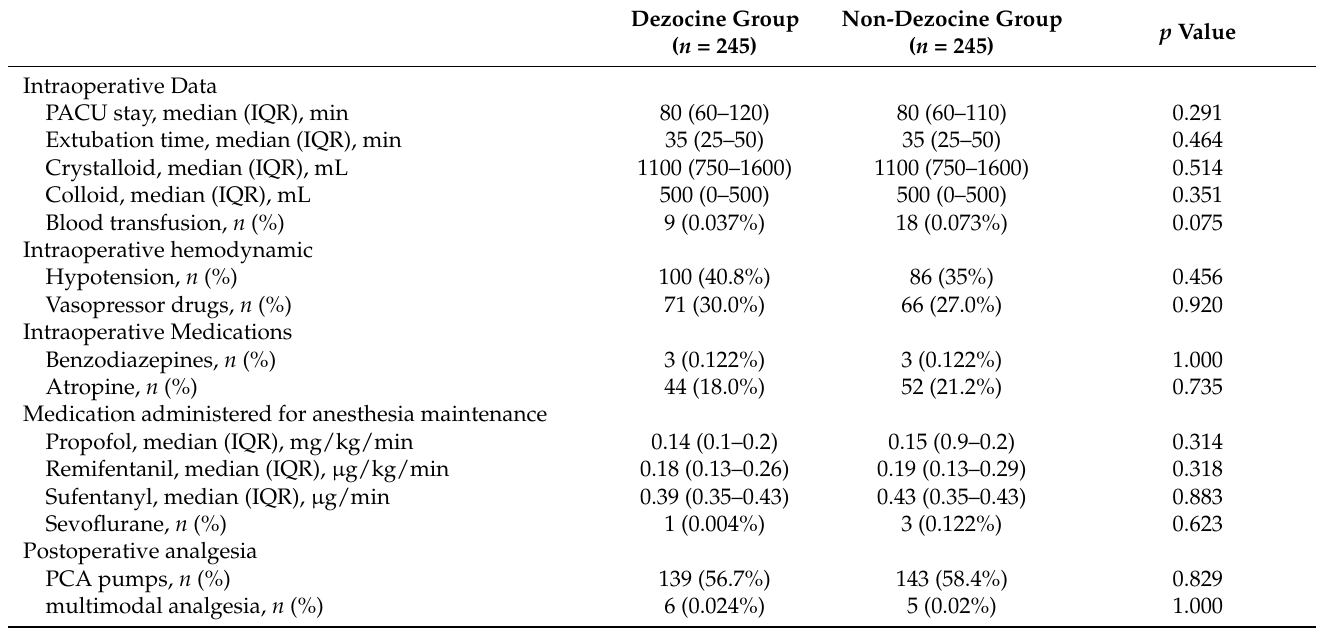
Table 5. Perioperative characteristics of the two study